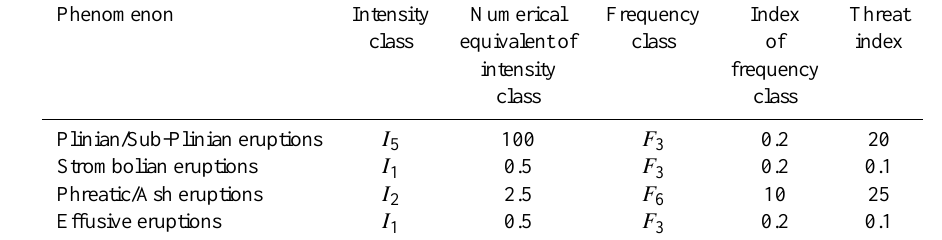
Table 7. Threat index calculated for each considered phenomenon.